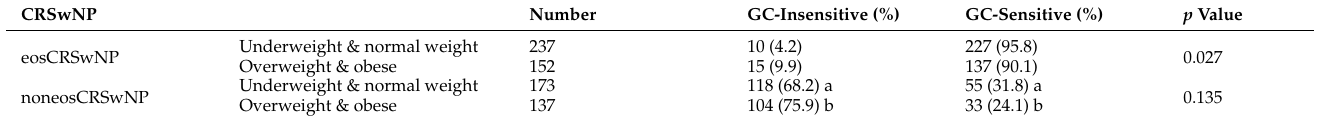
Table 2. Glucocorticoid (GC) insensitivity rates in each subgroup.